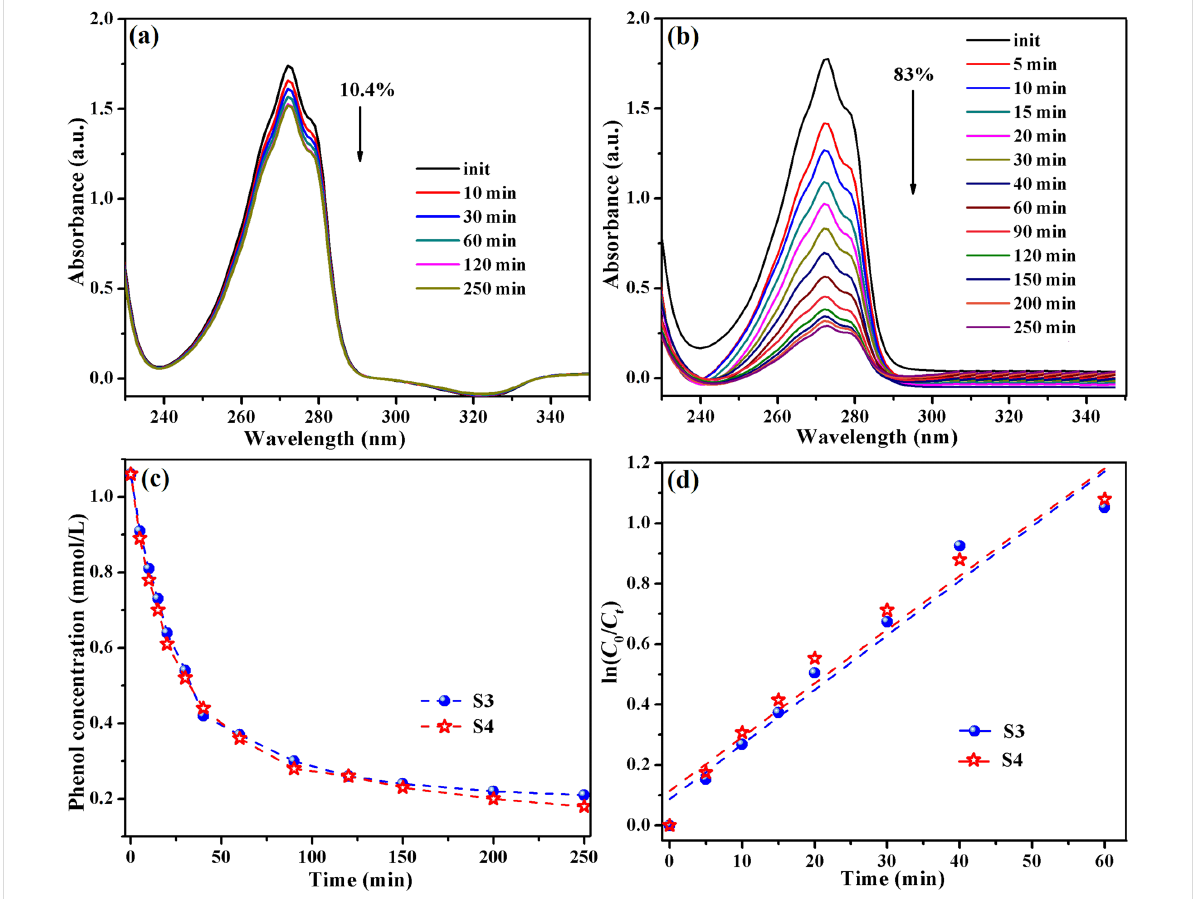
Figure 7: Changes of UV–vis absorption spectra of an aqueous phenol solution in the presence of S1 (a) and S4 (b) hybrids monitored as a function of the time of visible-light irradiation; temporal evolution of the phenol concentration (c) and fitted curves for the kinetic estimation of phenol photodeg- radation